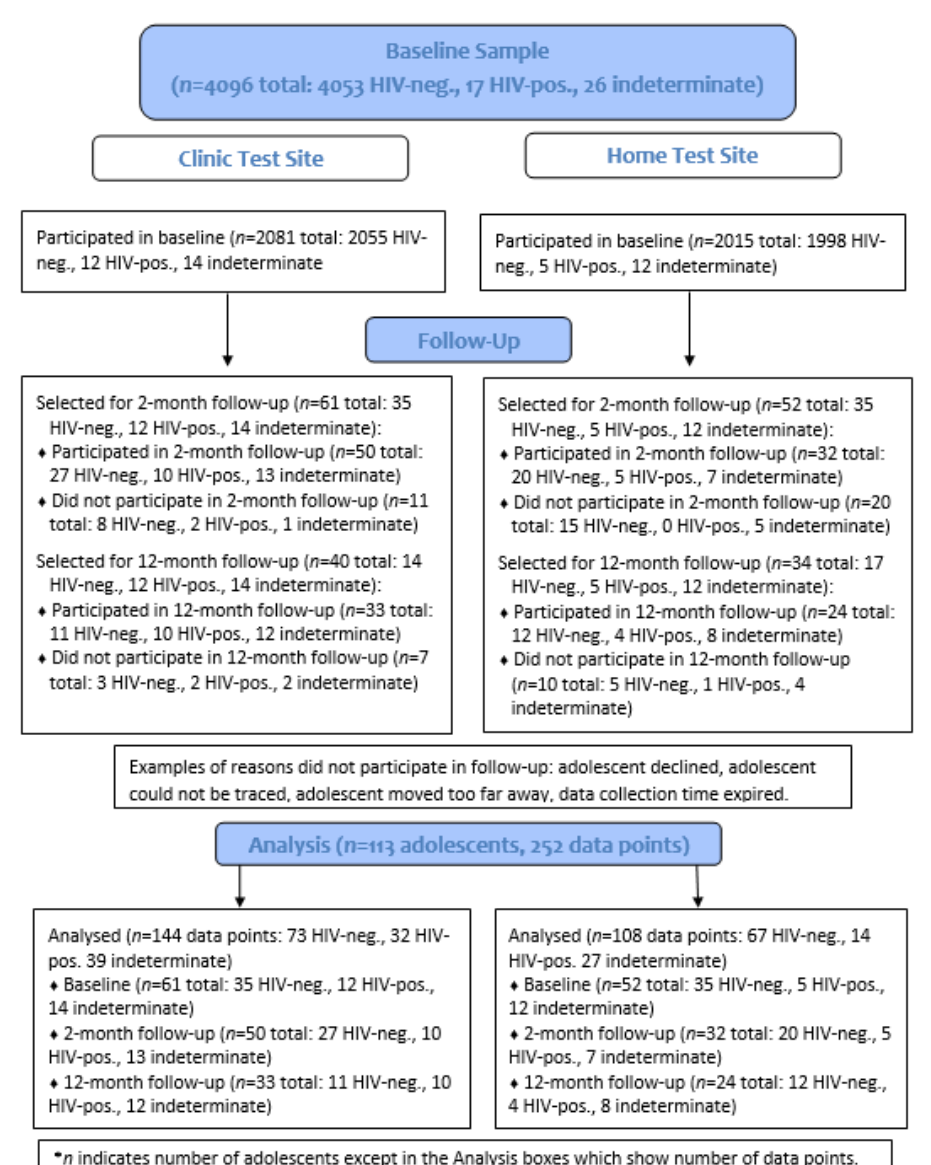
Figure 1. Case Flow Diagram of Study Participants.